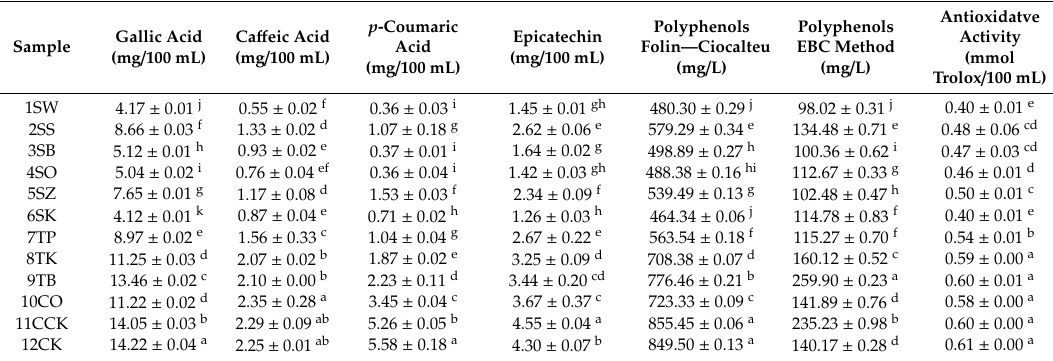
Table 3. Content of polyphenols and antioxidative activity of analyzed